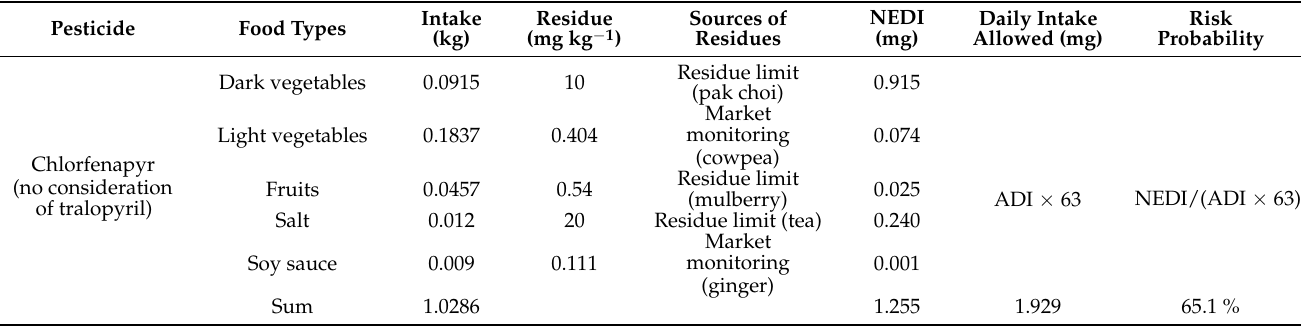
Table 4. Calculation table for dietary risk assessment of chlorfenapyr and